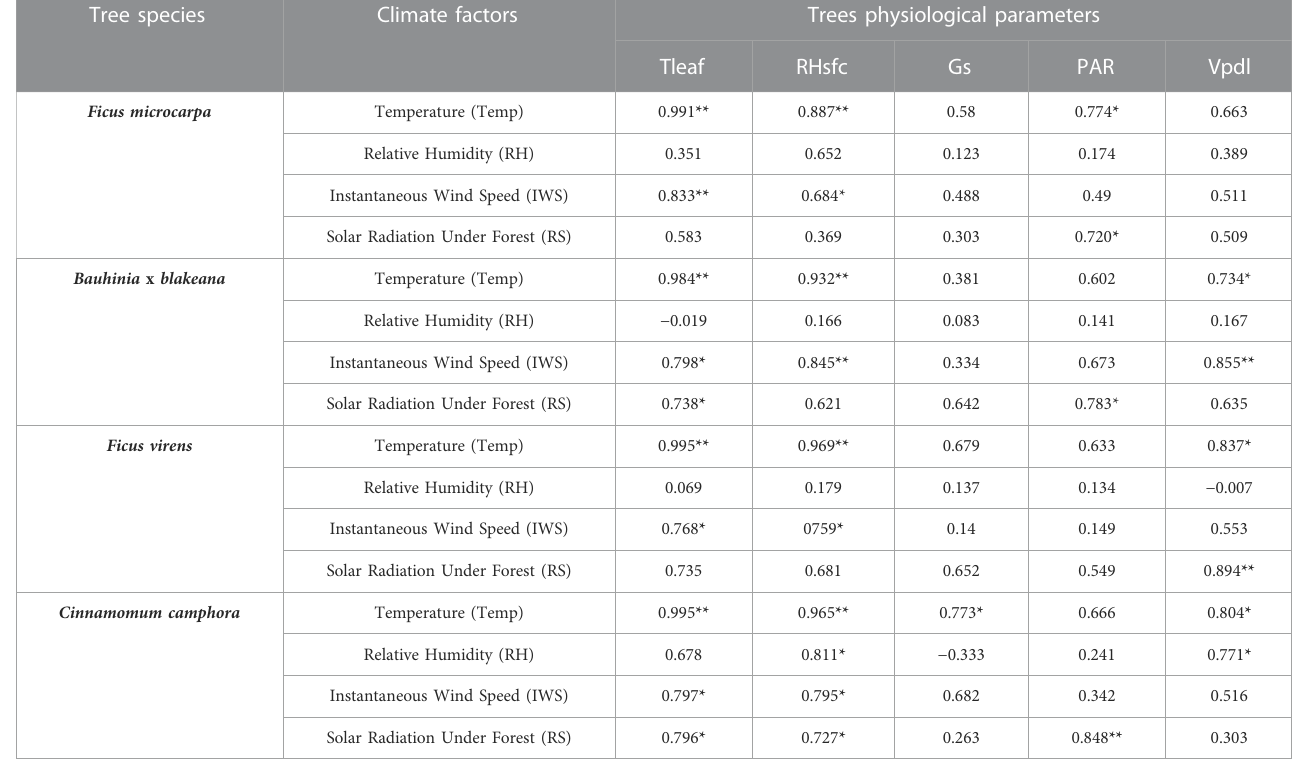
TABLE 5 Correlation of physiological parameters of trees with microclimatic factors. Tree species Climate factors Trees physiological